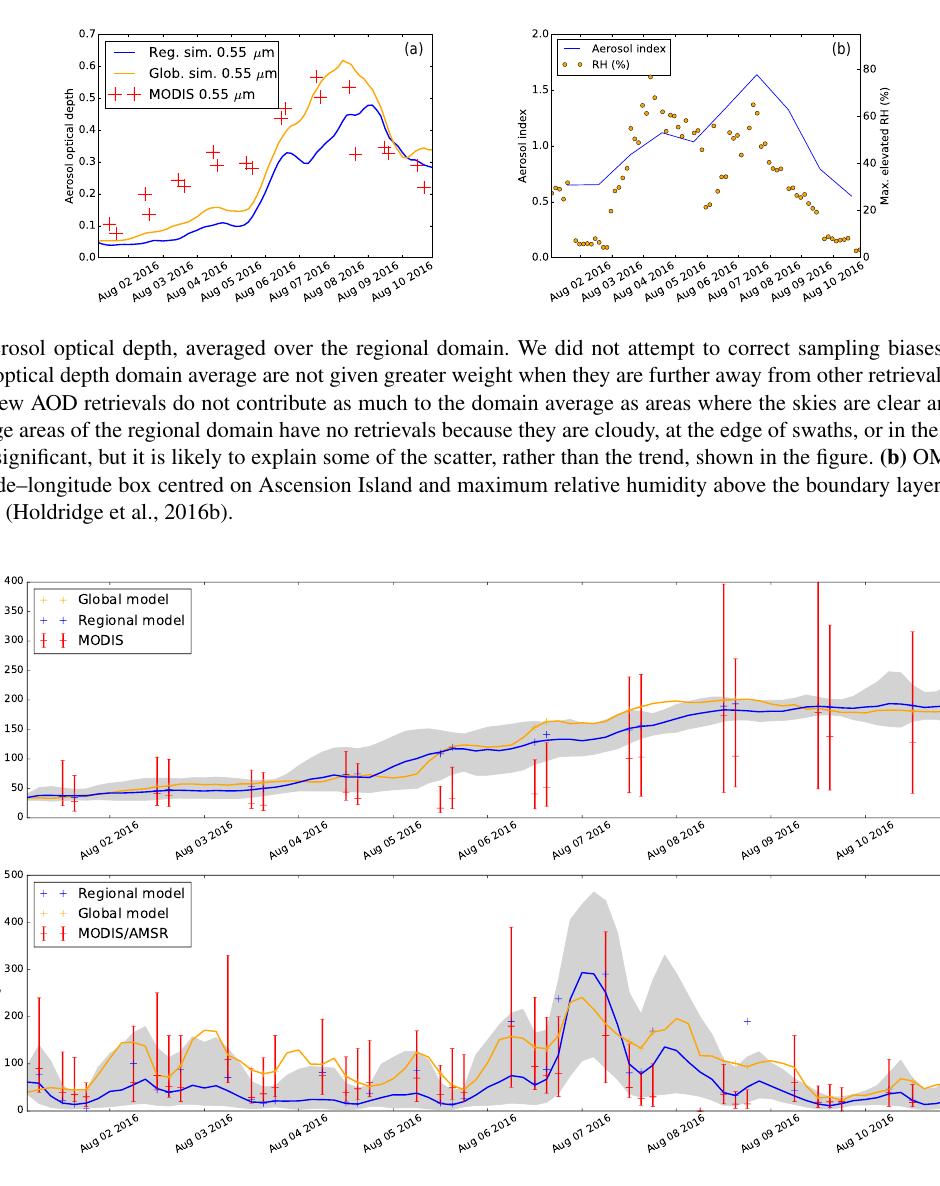
Figure 9. Time series of cloud droplet number concentration at the cloud top and in-cloud liquid water path in the model (a median within approximately 800km of the centre of the domain) compared to corresponding AMSR and MODIS observations across the same area at matched times. The MODIS data were regridded to the resolution of the regional model. Cloudy grid boxes are defined as those with LWP above 10gm − 2 . The interquartile ranges in the satellite data are shown as error bars, and the range (inner half of the distribution) in the regional model as a grey band. Where the blue crosses deviate from the overall domain median indicated by the blue lines, the regional model data were regridded to the AMSR resolution and averaged only inside the AMSR swaths, or calculated only inside the MODIS swaths. Thus the blue and red crosses are directly comparable. No correction for swaths was made in the lower resolution global model data; hence, the orange crosses lie on the orange lines and the blue and red crosses are only approximately comparable with the orange crosses. The effects of smoke aerosol on these quantities are presented and discussed later, in Fig.